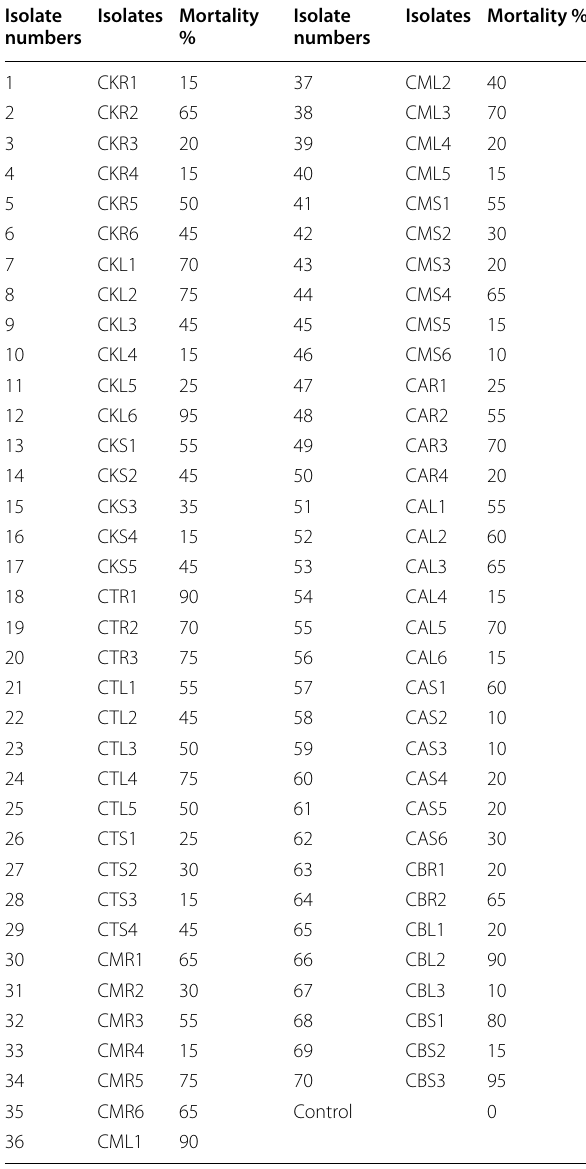
Table 1 Pathogenicity of some bacterial isolates on newly hatched spiny bollworm